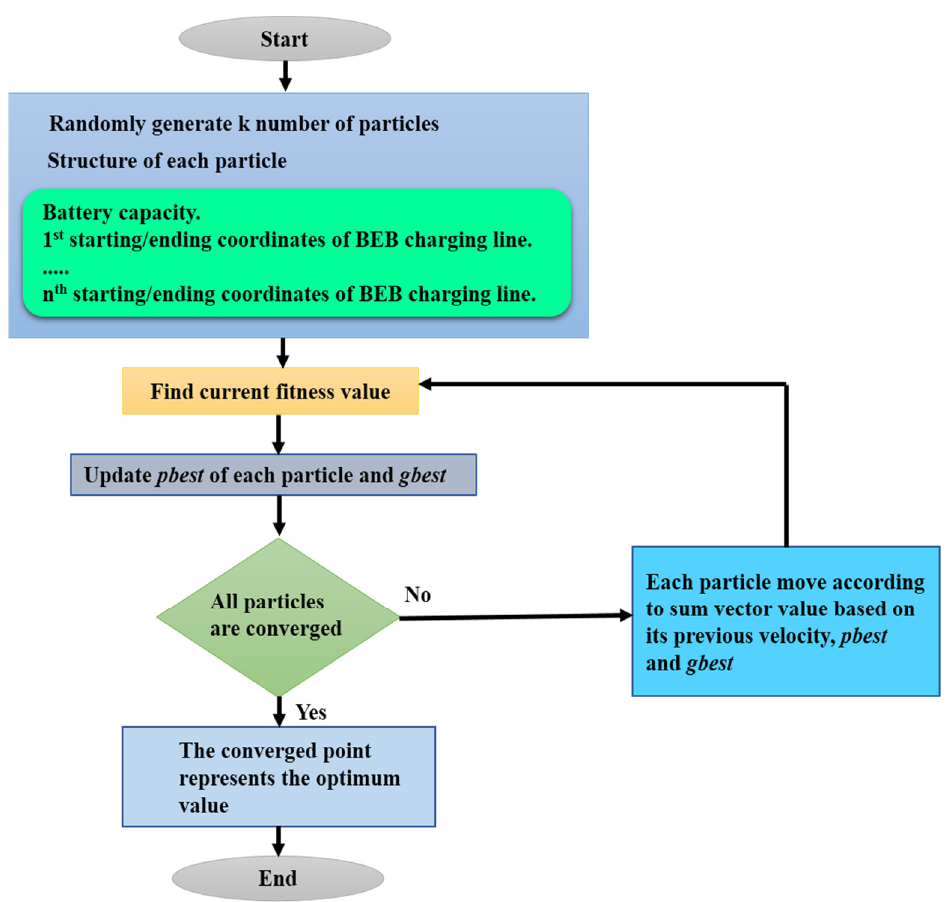
Figure 9. Solution procedure with PSO algorithm of the optimization problem for estimation of highly accurate values of BEB energy consumption.